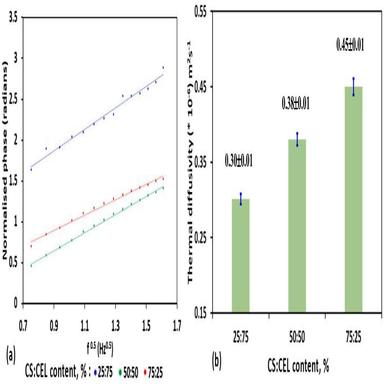
Plot of (a) normalized PEE phase (radians) vs. f 0.5 and (b) the values of thermal diffusivities determined for biocomposites with different CS:CEL content.